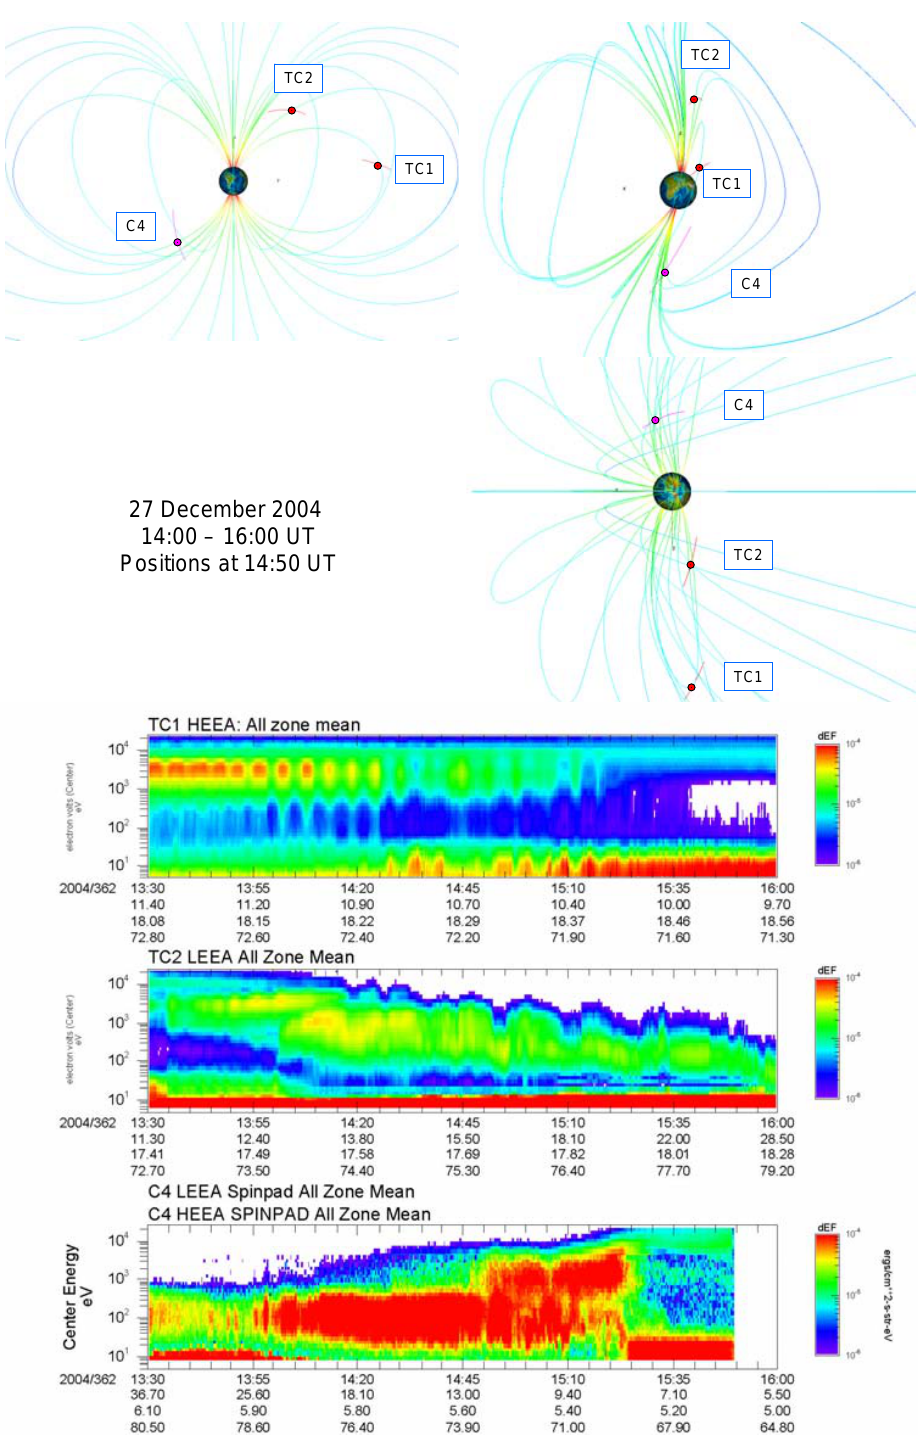
Fig. 17. Above, 27 December 2004, orbital positions and OVT model magnetosphere in GSM, views from X, Y and Z; below, PEACE data Figure 17: above, December 27 th 2004, orbital positions and OVT model magnetosphere from TC-1, TC-2 and C4. X-axis labels show UT time, L-shell, MLT and invariant in GSM, views from X, Y and Z; below, PEACE data from TC1, TC2 and C4. X-axis labels show UT time, L-shell, MLT and invariant latitude.